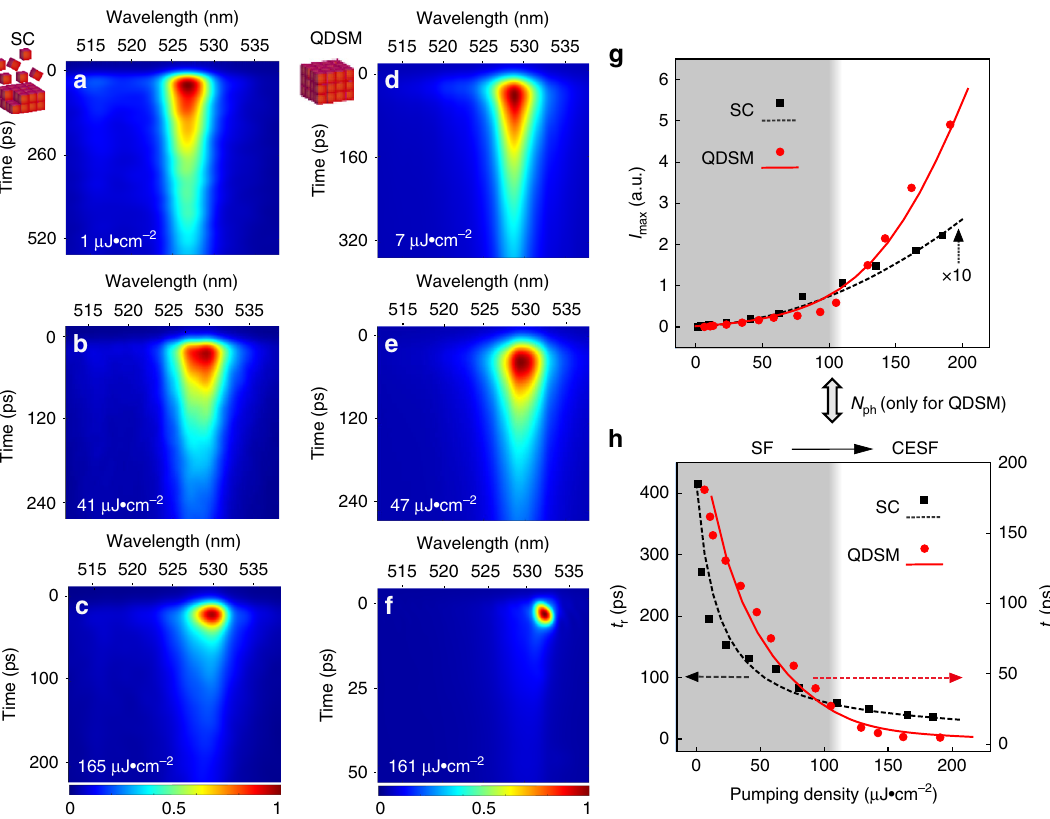
Fig. 3 Dynamics of SF and CESF under different pumping densities. a – c Streak-camera images of SF behavior in a SC sample at 77 K. d – f Corresponding data for CESF in a QDSM sample. g Peak intensity I max of SF/CESF signals vs. pumping density. The dots represent experimental data and the lines represent theoretical simulations. h Power dependences of radiative time t r . As shown in g , h , the CESF effect in the QDSM exhibits an obvious pumping threshold. Here, N ph represents the threshold density of stimulated photon ampli fi cation in the